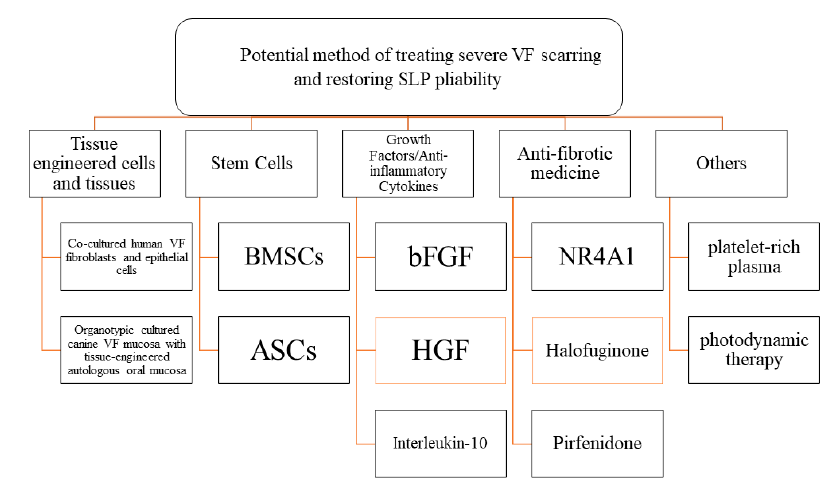
Figure 1. Organizational chart showing current potential treatment strategies for restoring vocal fold (VF) pliability. BMSCs, bone marrow-derived mesenchymal stromal cells; ASCs, adipose-derived stem / stromal cells; bFGF, basic fibroblast growth factor; HGF, hepatocyte growth factor; NR4A1, orphan nuclear receptor 4A1.